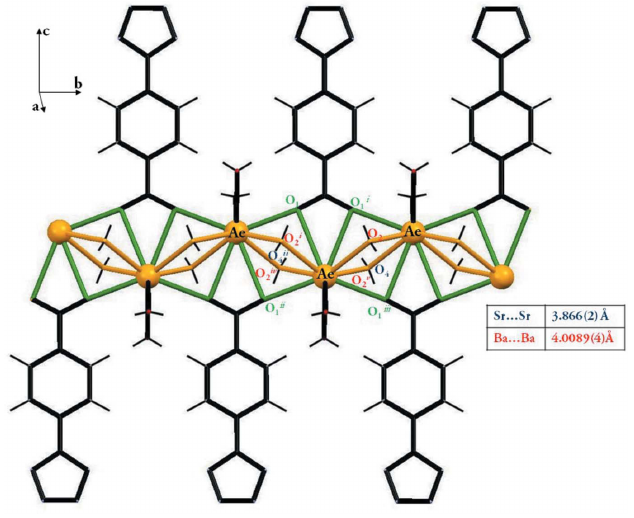
Figure 3 Coordinating polymers along the b